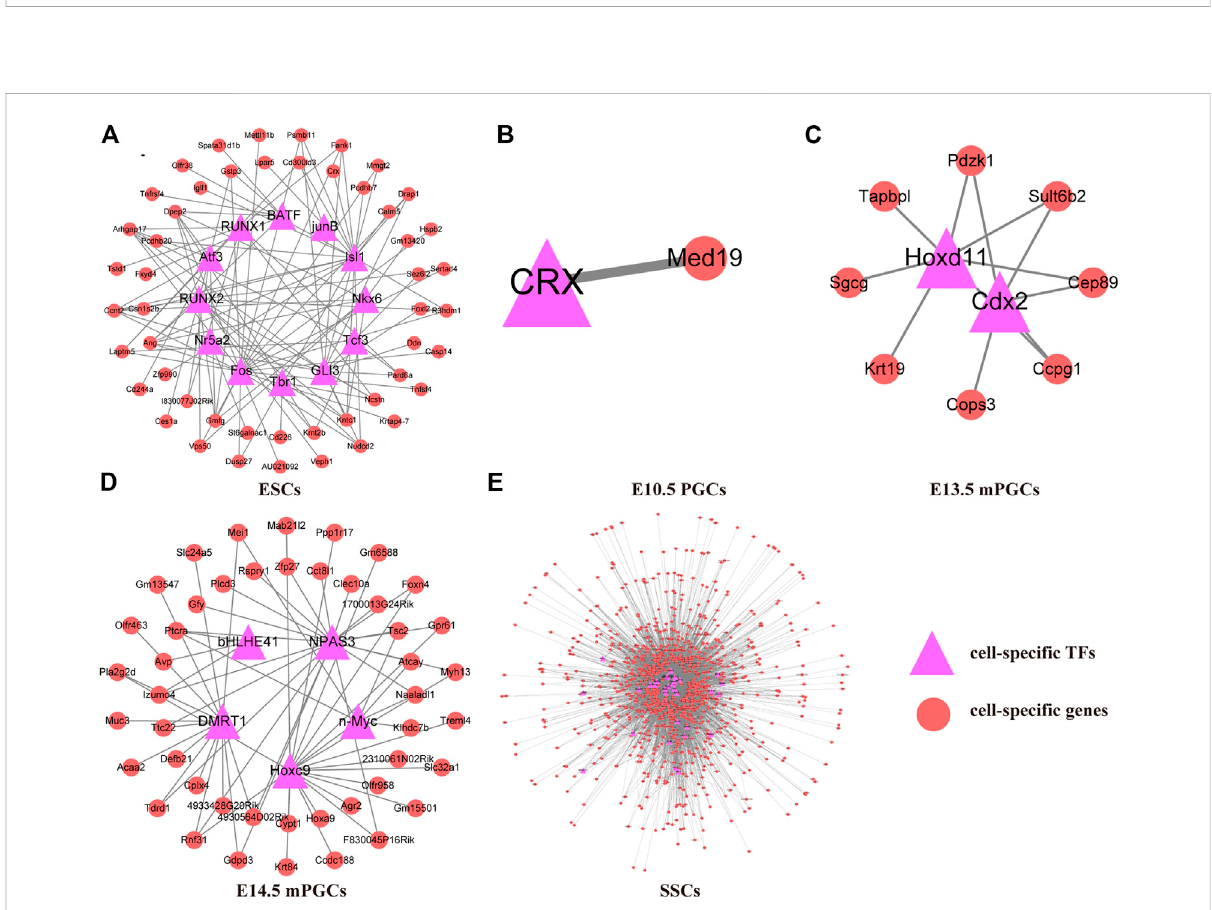
FIGURE 4 TF-mediated GRNs of ESCs, PGCs, and SSCs. (A) ESCs. (B) E10.5 PGCs. (C) E13.5 mPGCs. (D) E14.5 mPGCs. (E) SSCs.